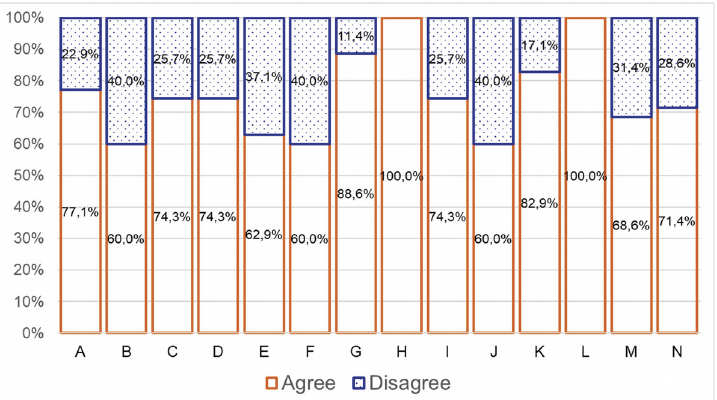
Figure 8. Survey result 3: Students’ perception of the various